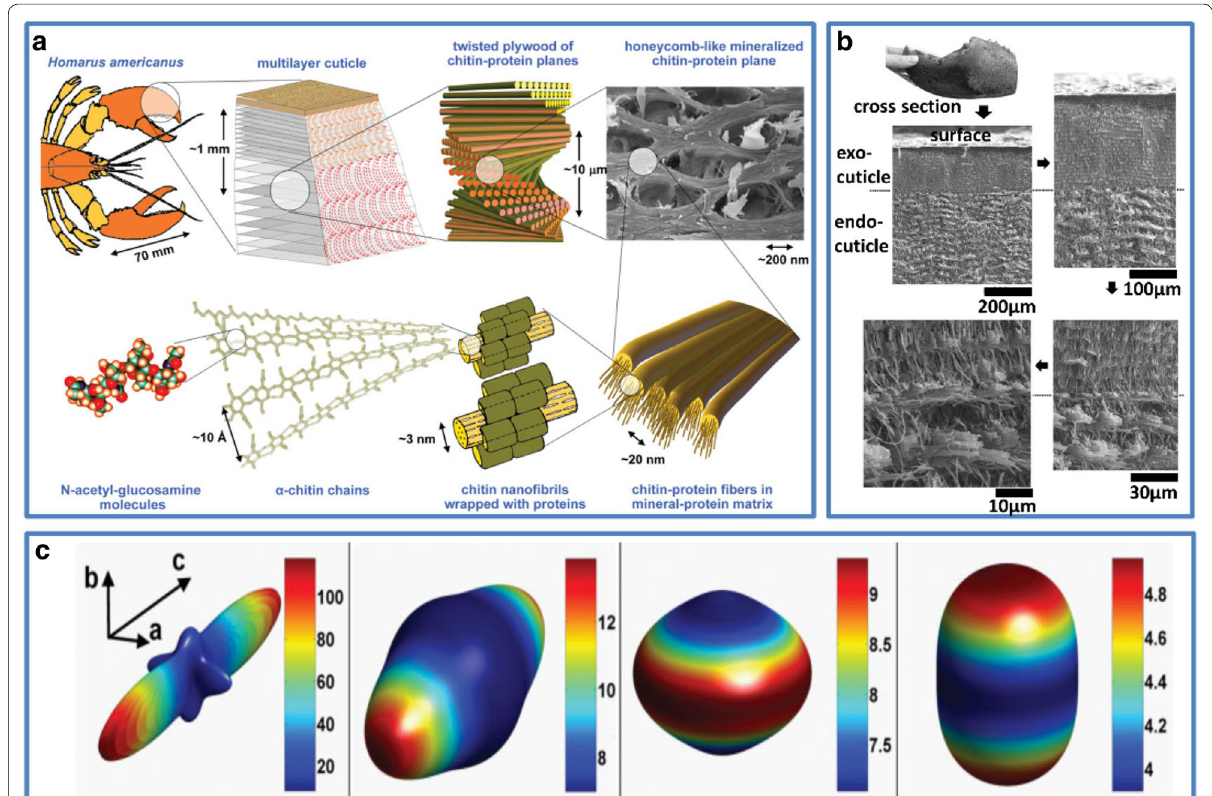
Figure 7 ( a ) The twisted plywood structure of the lobster cuticle ( Homarus americanus ) [85]; ( b ) SEM micrographs of the fractured surfaces of the lobster cuticle at increased resolution [23]; ( c ) 3D maps of the Young’s modulus for different hierarchical structure units (α-chitin chains,